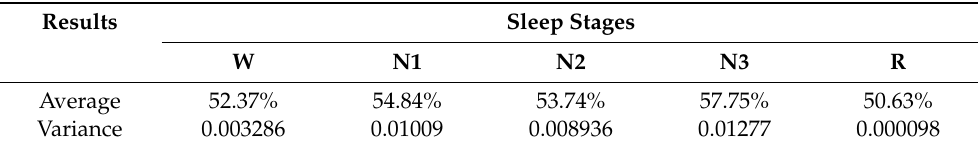
Table 5. The average accuracy and variance of accuracy of using 1-NN classifier to evaluate the distribution of data generated by GANs for each sleep